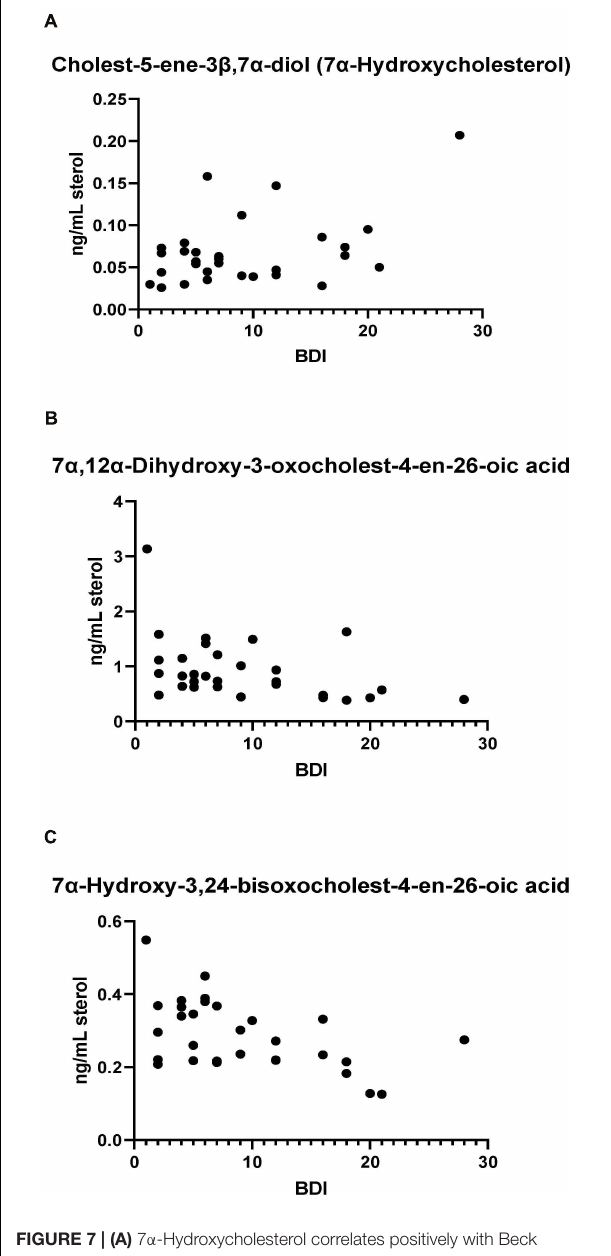
FIGURE 7 | (A) 7 α -Hydroxycholesterol correlates positively with Beck Depression Inventory (BDI) scores while presumptively identified acids, (B) 7 α ,12 α -dihydroxy-3-oxochelest-4-en-26-oic, and (C) 7 α -hydroxy-3,24- bis oxocholest-4-en-26-oic acids show negative correlations with the BDI